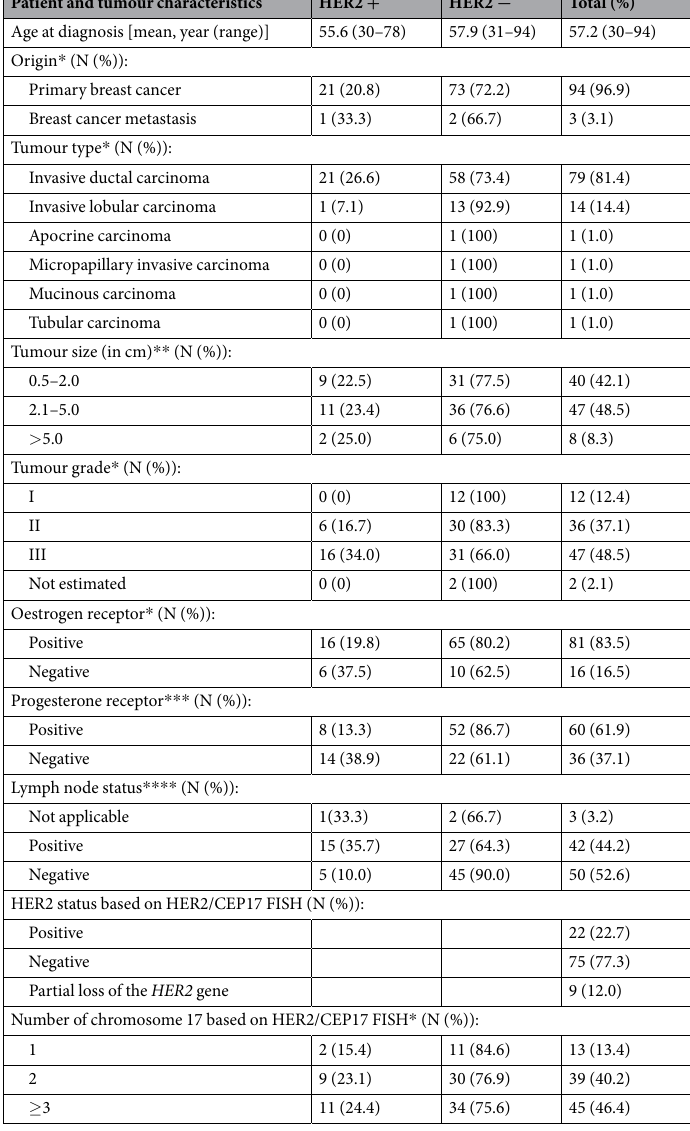
Table 2. Patient and tumour characteristics. * For total of 97 tumours. N: number of cases. ** For total of 95 tumours. For two samples the tumour size was unknown/not applicable. *** For total of 96 tumours. Progesterone receptor status was not determined on 1 tumour sample. **** For total of 95